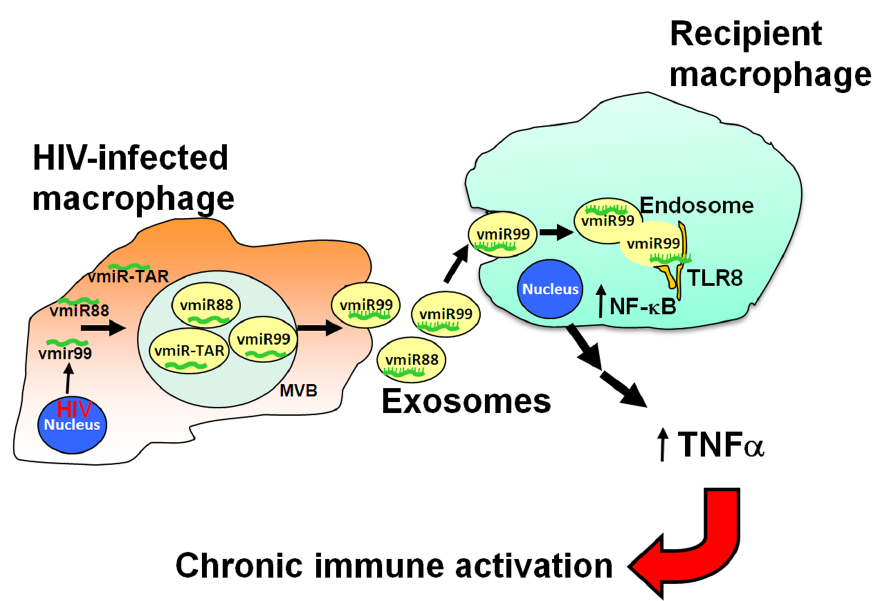
Figure 6. Working model of HIV-produced miRNA activation of bystander cells in HIV + persons. This figure provides a working model describing how HIV-produced miRNAs are encapsulated in exosomes and released from HIV-infected macrophages into the circulation. Host RNA polymerases transcribe HIV genomic RNA, which is then exported into the cytoplasm and packaged into infectious virions. However, some HIV transcripts can be processed in the host RNA interference pathway into mature viral miRNA. HIV miRNAs are packaged into multi-vesicular bodies and released by macrophages encapsulated in exosomes. Exosomes are disseminated either locally or systemically to be taken up by bystander macrophages, trafficking GU-rich vmiR88 and vmiR99 to the endosomal TLR8. Through this non-RNAi function of miRNAs that is distinct from the well-established role of miRNAs in RNA interference, vmiR88 and vmiR99 induce TLR8-mediated inflammatory signaling pathway that leads to downstream release of TNF a leading to chronic immune activation.